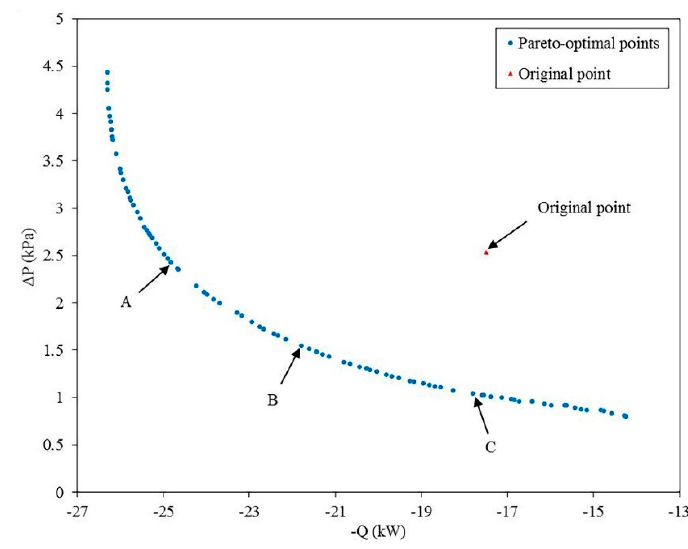
Figure 17. Pareto optimal points.